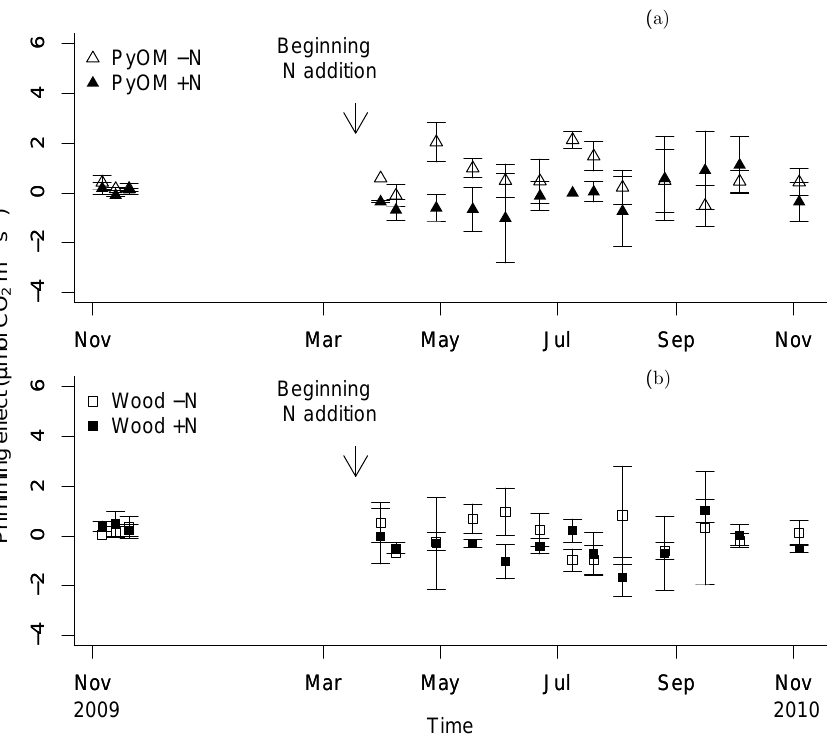
Figure 4 Figure 4. Priming effect induced by PyOM (a) and wood (b) in µmol CO 2 m − 2 s − 1 , derived from Eq. (2). Unshaded symbols represent the treatment under ambient N and the black symbols represent the treatment under increased N. Error bars represent the standard error of the mean ( n =